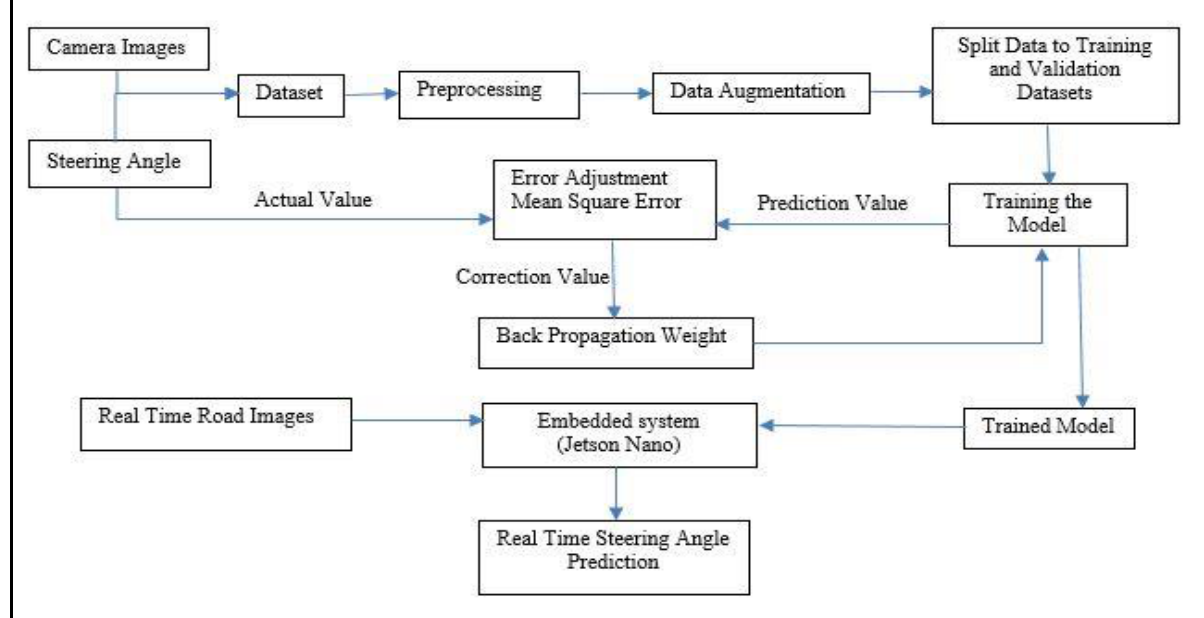
Fig. 4. Block diagram of the training